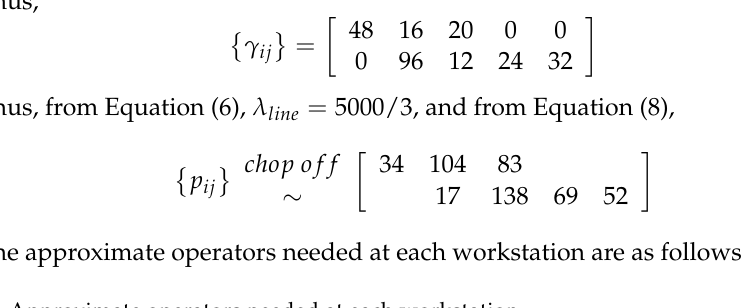
Table 4. Approximate operators needed at each workstation.